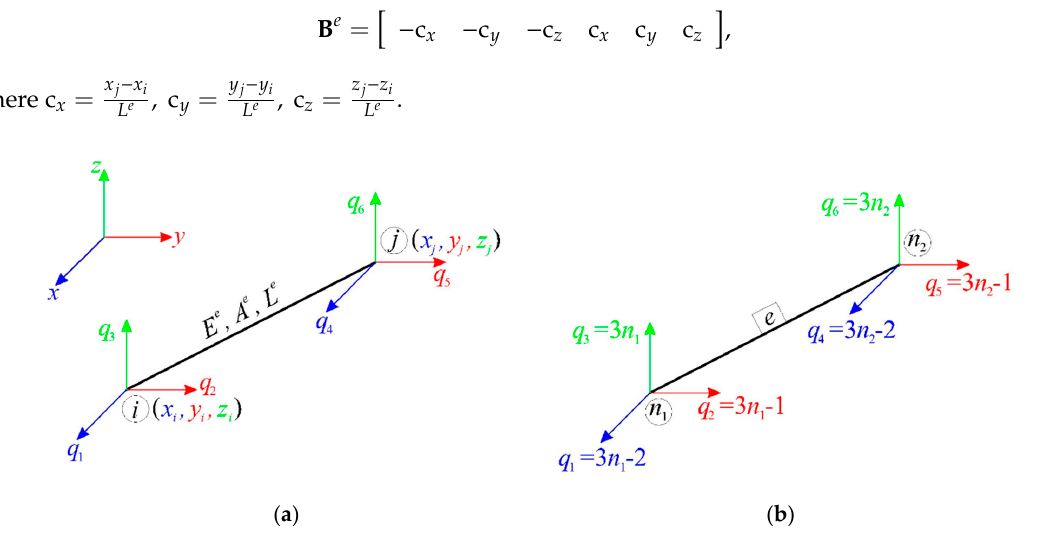
Figure 5. ( a ) Space truss finite element, ( b ) global degrees of freedom of element e